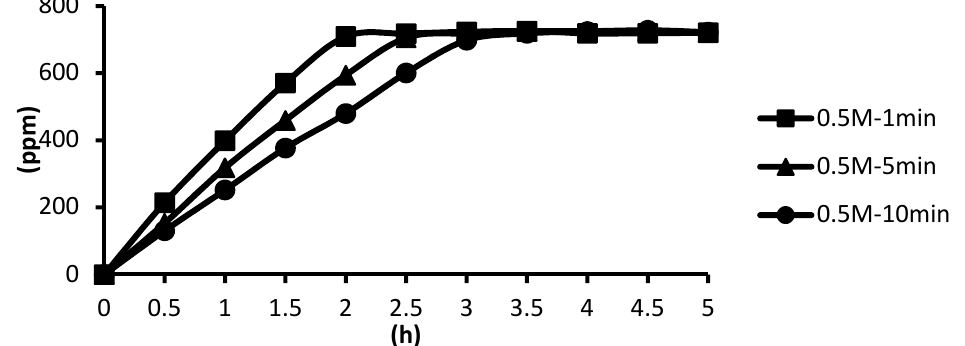
Figure 16. The effect of cross-linking time by 0.5 M ZnCl 2 on releasing of tea tree essential oil from alginate/tea tree essential oil microcapsules in the hot spring water.